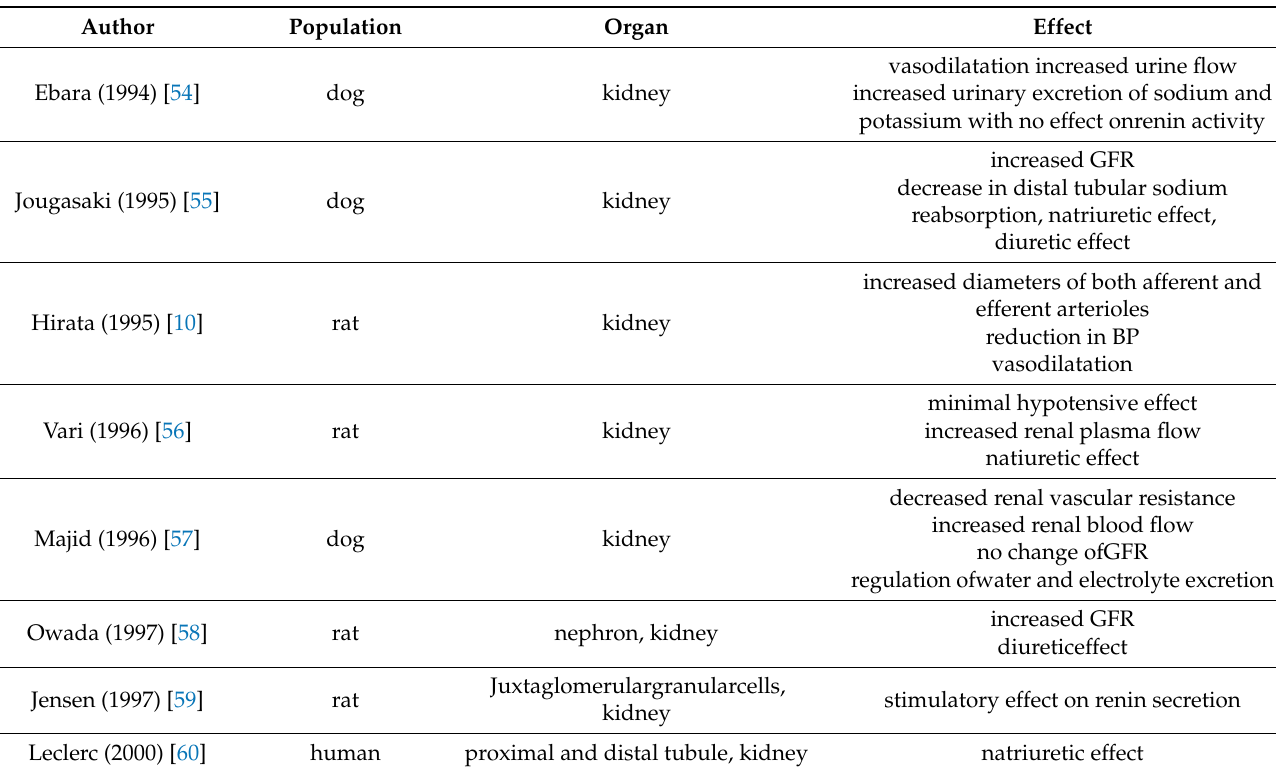
Table 2. Studies evaluating the effects of ADM on